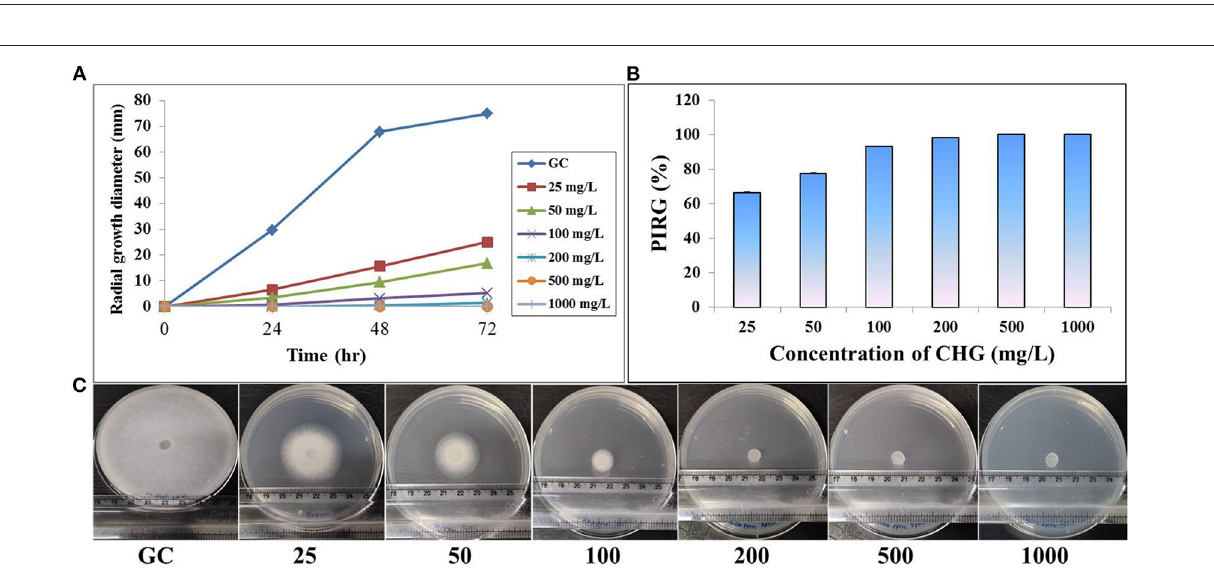
FIGURE 3 | Effect of CHG on radial growth of Saprolegnia parasitica. (A) Time dependent mycelial growth of S. parasitica on glucose yeast extract agar incorporated with different concentrations of chlorhexidine (0, 25, 50, 100, 200, 500 and 1000 mg/L). (B) Estimation of percent inhibition on radial growth of S. parasitica on CHG incorporated glucose yeast extract at 72 hr. (C) Full grown hyphae in growth control (GC) and reduced or absence of hyphal growth in CHG treated plates at 72